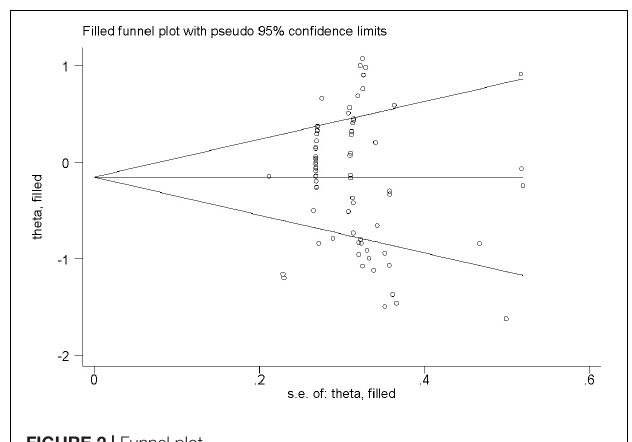
FIGURE 2 | Funnel